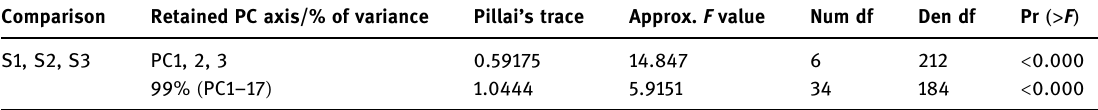
Table 2: MANOVA output